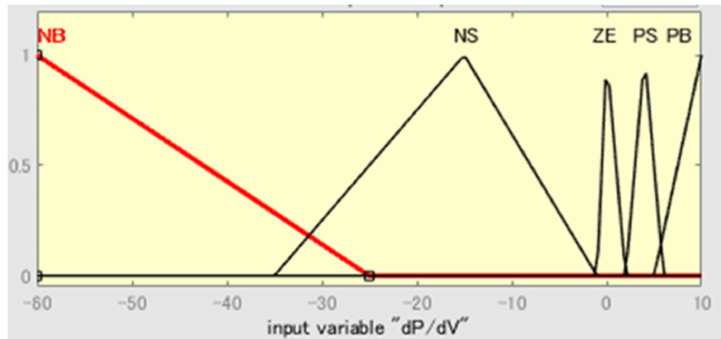
Figure 8. PV fuzzy logic control (FLC) membership function for E [19].